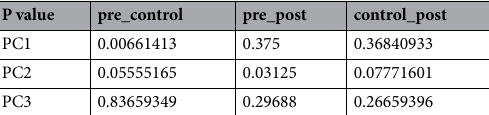
Table 1. PCoA based on OTU